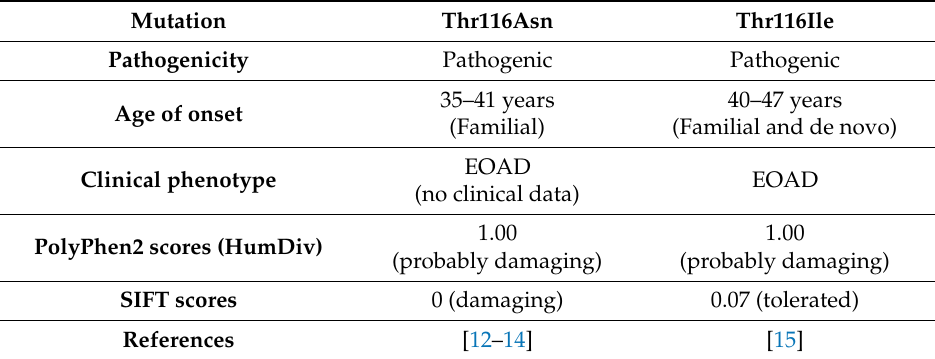
Table 2. Comparison of PSEN1 Thr116Ile with